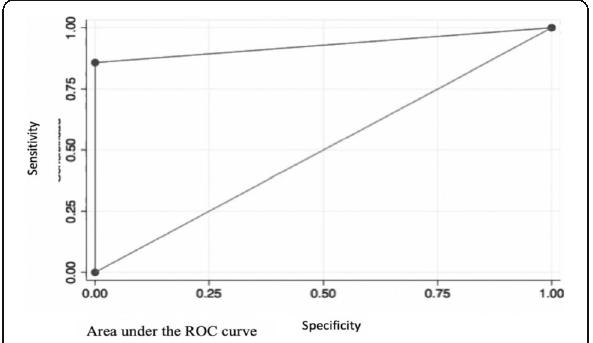
Fig. 1 (abstract 001268). Sensitivity and specificity. Area under the ROC curve for serum N-GAL in relation to the baseline diagnosis